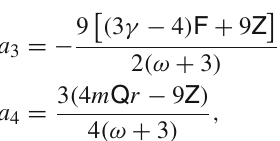
Fig. 3 Dynamical evolution of the Universe dominated by dust (γ = 1 ) . The initial values for numerical integration of the system (49)–(52) along with model parameters have been set as, ω = − 2, r = − 48, X 0 = Y 0 = 0, Z 0 = 0 . 3340, Q 0 = − 0 . 0298 for the left panel and Z 0 = 0 . 309, Q 0 = − 0 . 0117 for outer orbits and Z 0 = 0 . 3496, Q 0 = − 0 . 003 for inner orbits of the right panel. The blue point exhibits the location of fixed points given by X ES = 0, Q ES = − 0 . 00162 (left